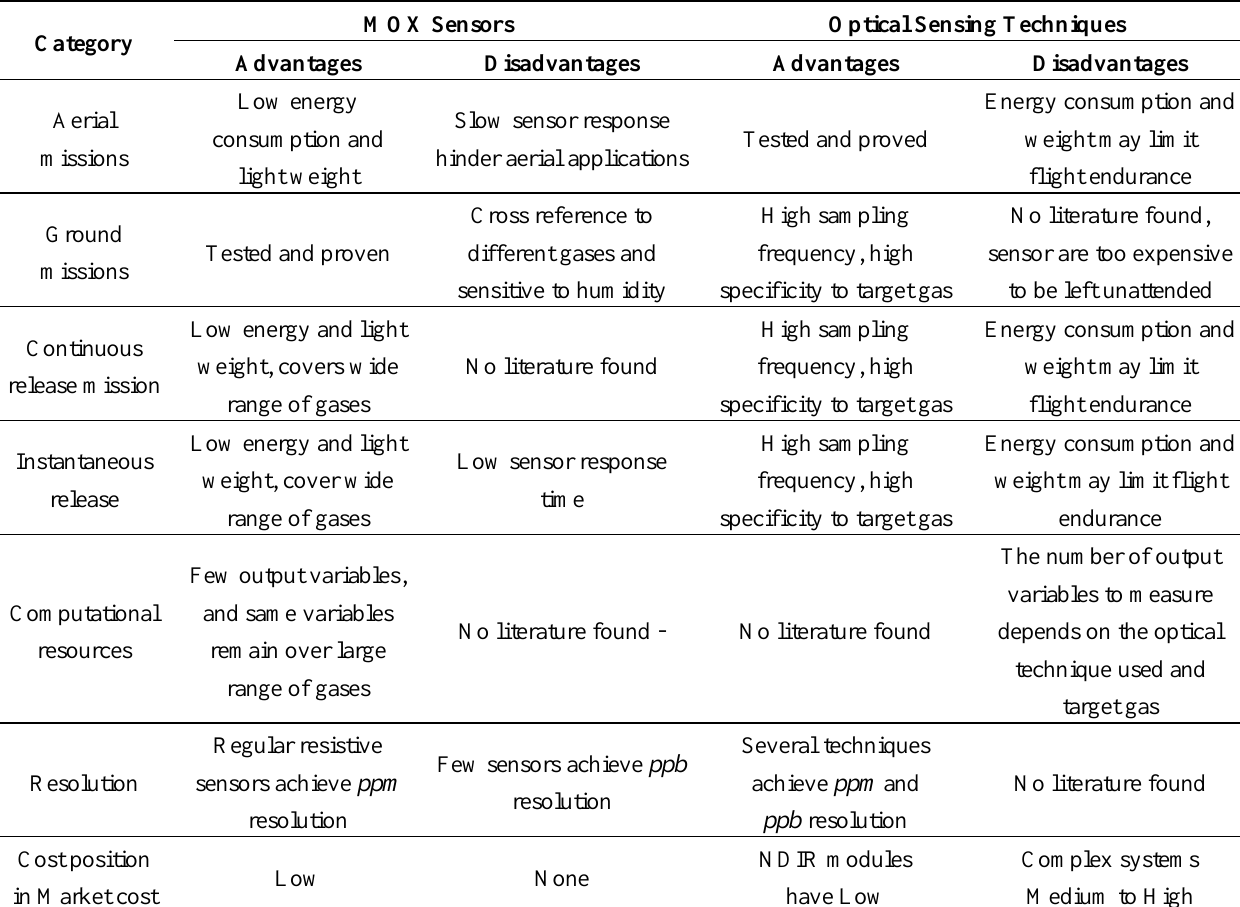
Table 1. Advantages and disadvantages of MOX and optical gas sensing technologies when used in WSNs and